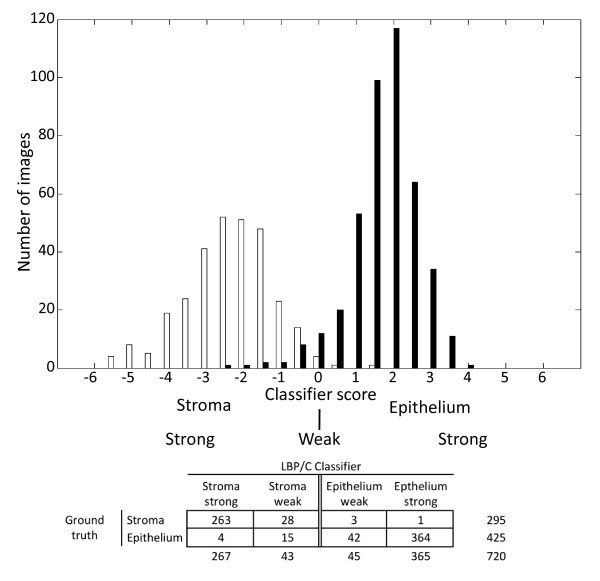
Contingency table for discrimination of colorectal cancer stroma and epithelium images in the test set (colorectal cancer images; n = 720) using the local binary pattern (LBP/C) classifier. The value of the score generated by the classifier defines to which class the test image is assigned, i.e. strong or weak epithelium (black bars) or stroma (white bars)